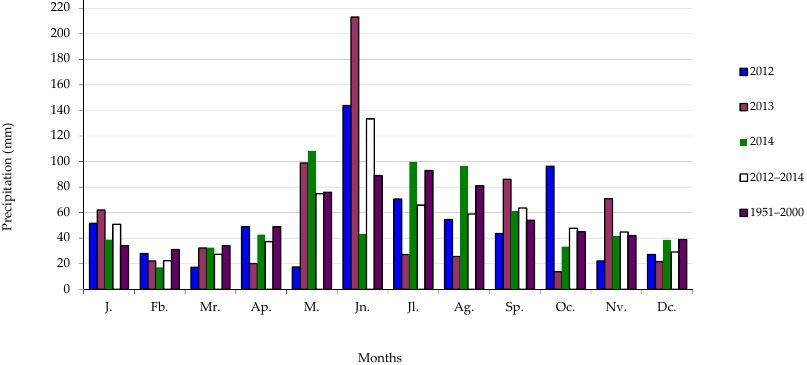
Figure 1. Sum of precipitation (mm) in particular months of 2012–2014 and multiyear 1951–2000.